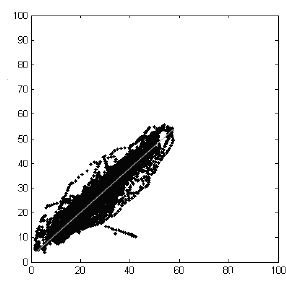
Fig. 16.9. 3 h ahead Forecast TEC values versus observed GPS-TEC results (dots) with the linear fit